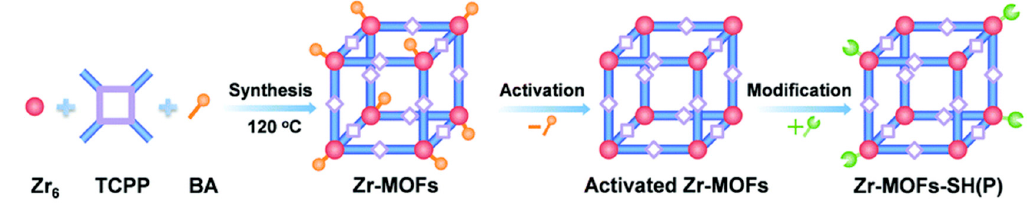
Figure 15. A schematic illustration of the synthesis of mercapto-functionalized Zr–MOFs (metal–organic frameworks) via the post-synthetic modification. Reprinted with permission from ref [112]. Copyright The Royal Society of Chemistry 2019.